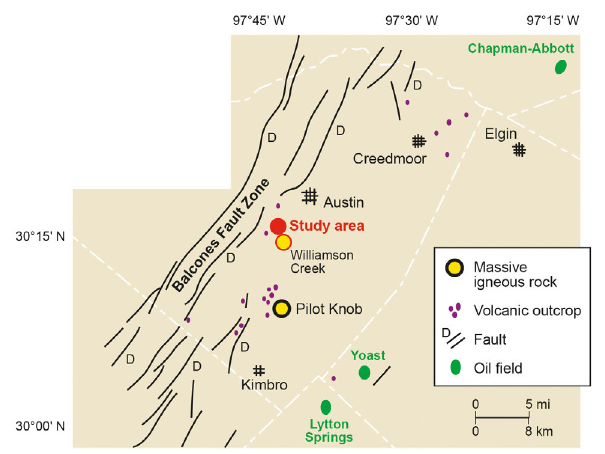
Figure 3: Map showing the current study area, William- son Creek and Pilot Knob sites, and volcanic oil fields (modified from Saribudak and Caran